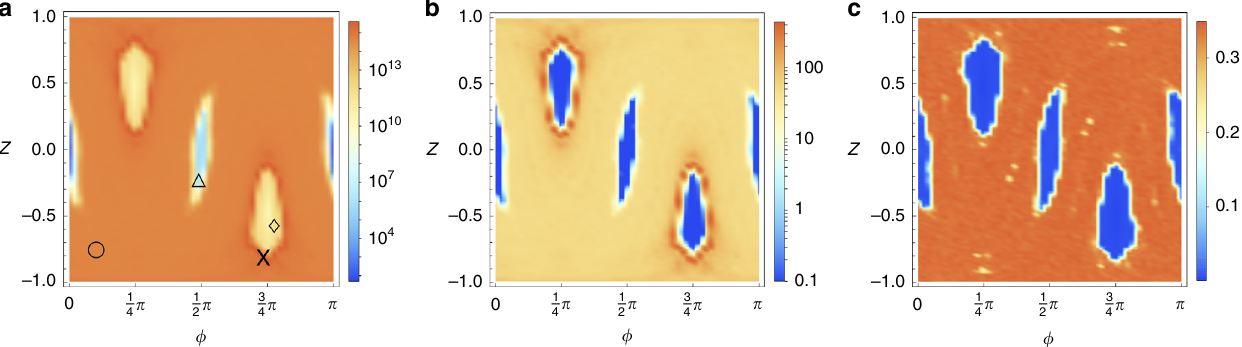
Fig. 3 Portraits of a mixed phase space for large spin size j = 4000. The heat maps depict quantum Fisher information (QFI) in panel a and gain Γ in panel b at time t = 2 15 and kicking strength k = 3. Γ < 0.1 is depicted as Γ = 0.1 to simplify the representation. A gain of more than two orders of magnitude in the QFI is observed for edge states, localized on the border of the stability islands. For comparison, panel c depicts the classical Lyapunov exponent λ